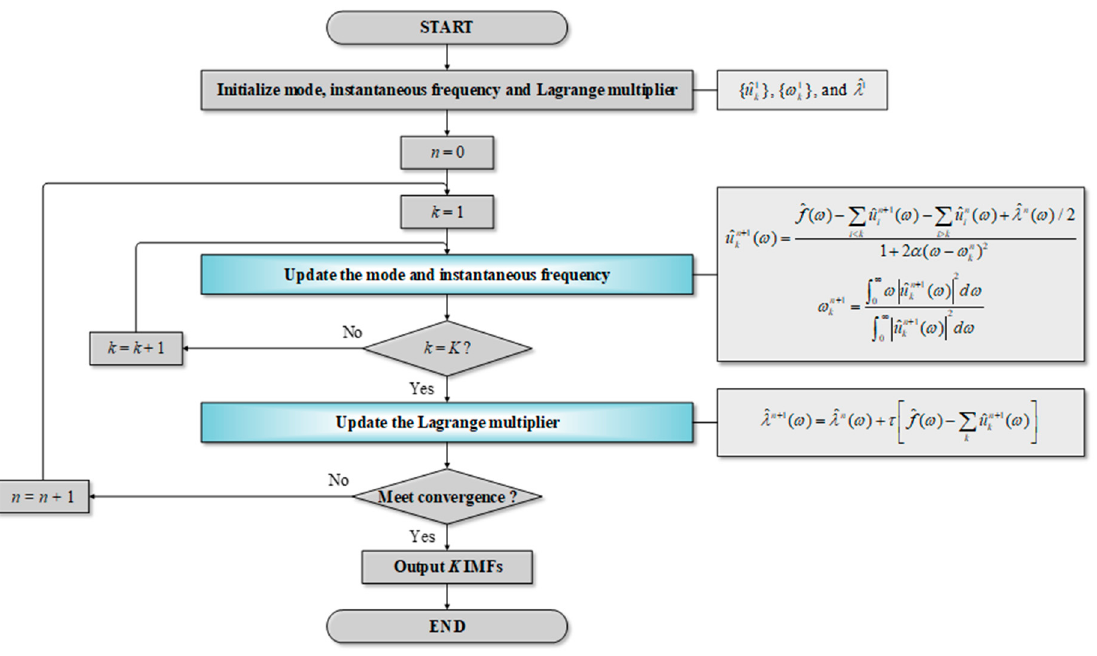
Figure 3. Flowchart for the variational mode decomposition (VMD) algorithm [73].